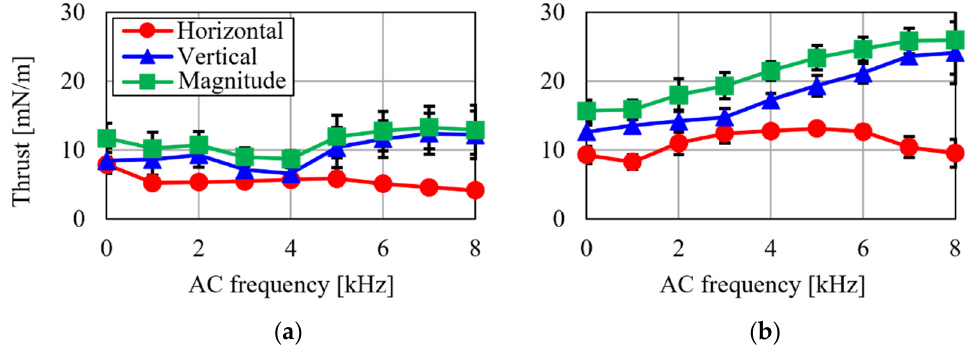
Figure 20. Thrust versus the frequency of the AC voltage when the AC voltage was 10 kV pp and the DC voltage was 14 kV in the ( a ) CD-PA and ( b ) TED-PA.